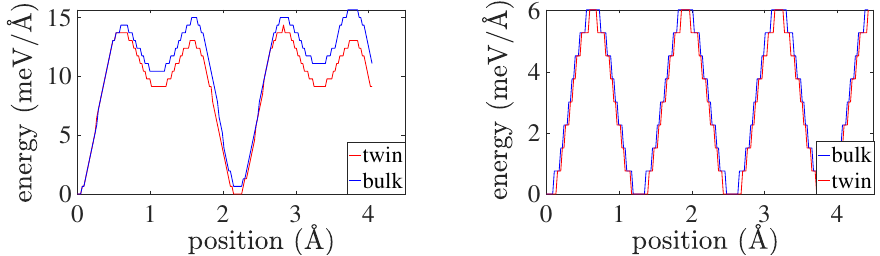
Figure 9. Unrelaxed simulation cell energy per unit dislocation length as a function of dislocation line (core) position for partial edge ( left ) and screw ( right ) dislocations in the bulk (blue) and on the twin boundary (red). As in Figure 8, position denotes x from Figure 2 in the direction of dislocation line motion m = i x